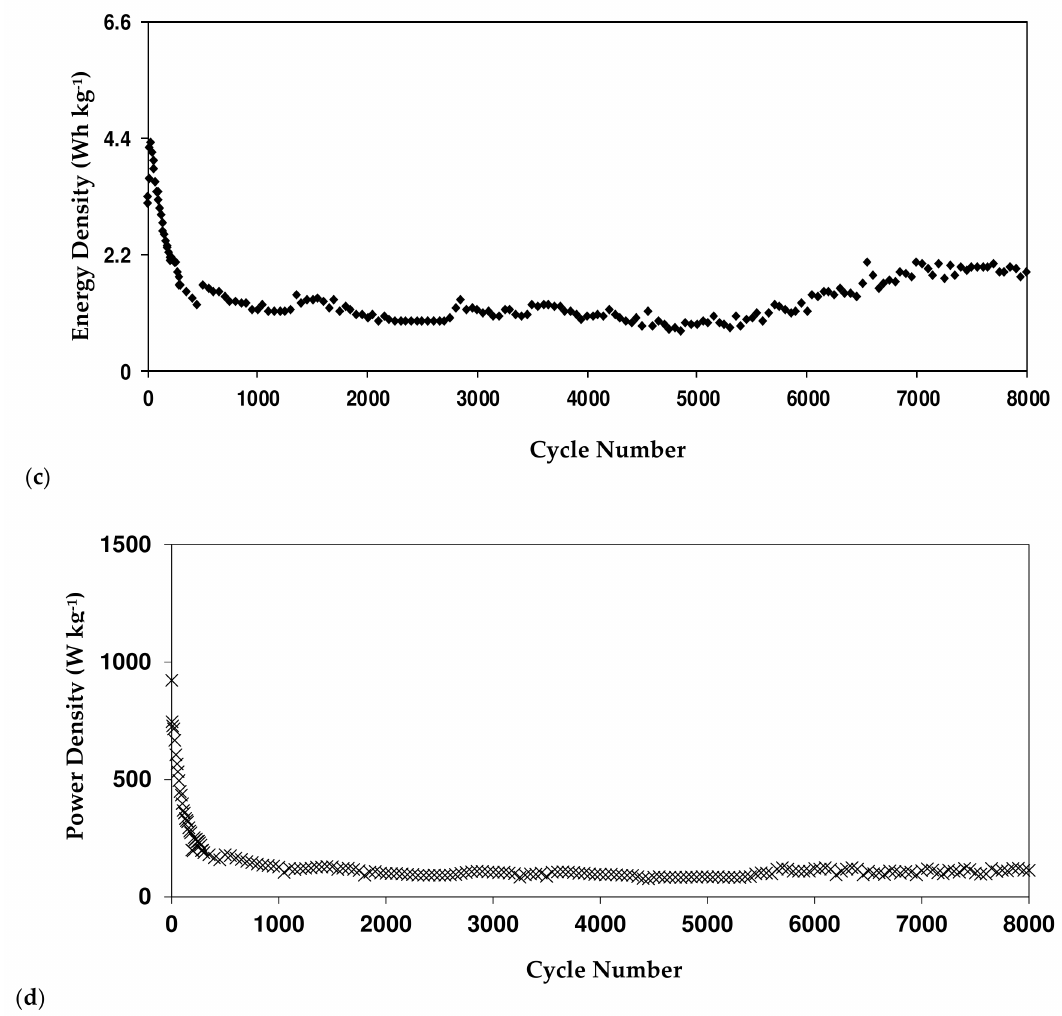
Figure 14. EDLC parameters: ( a ) specific capacitance, ( b ) equivalent series resistance, ( c ) energy density, and ( d ) power density of the EDLC for 8000